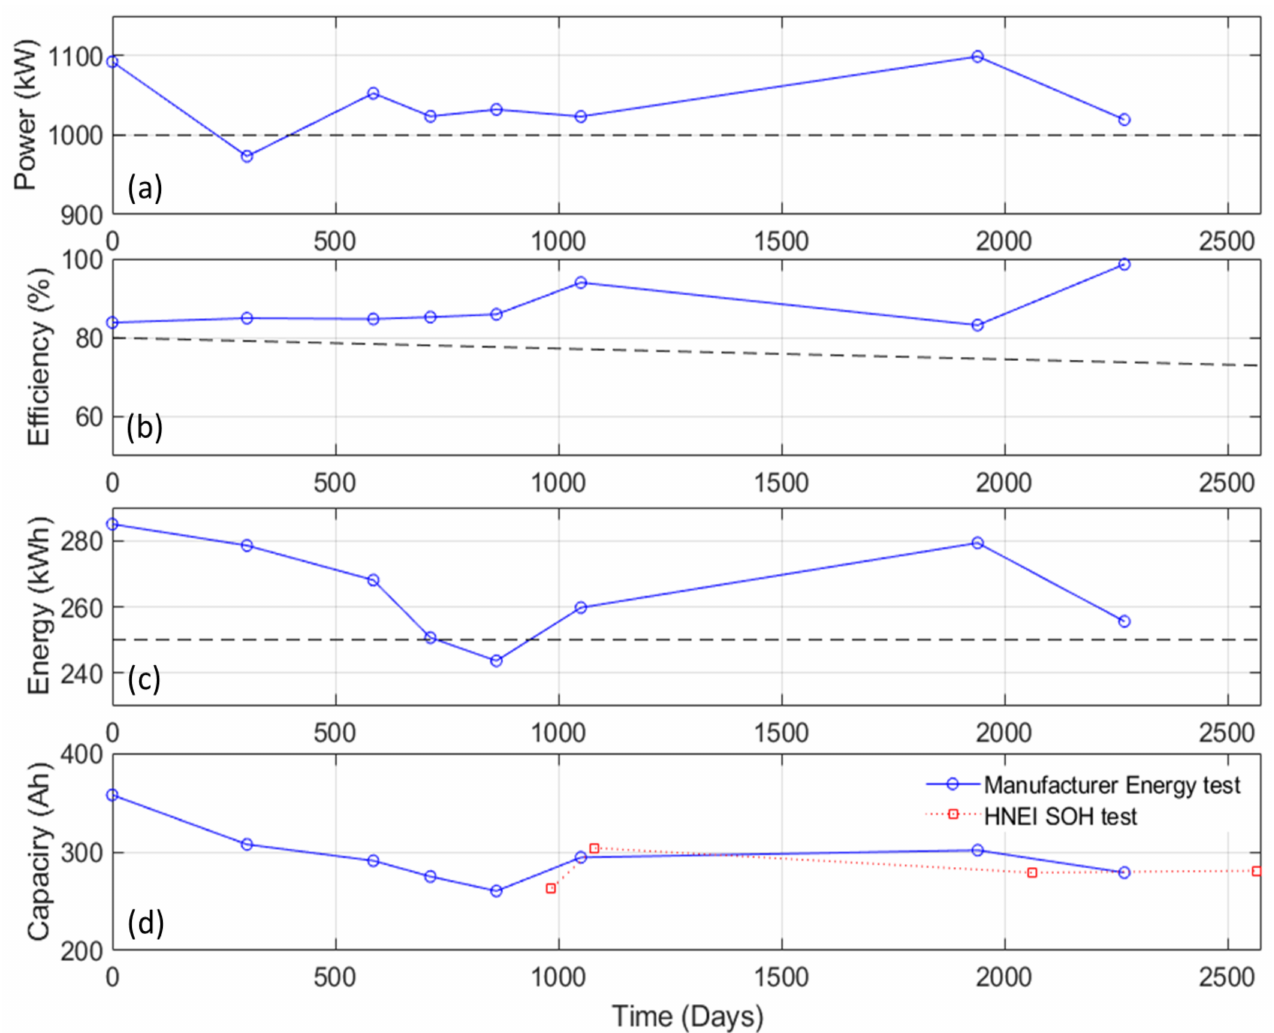
Figure 5. BESS ( a ) power, ( b ) efficiency, ( c ) energy, and ( d ) capacity evolution with